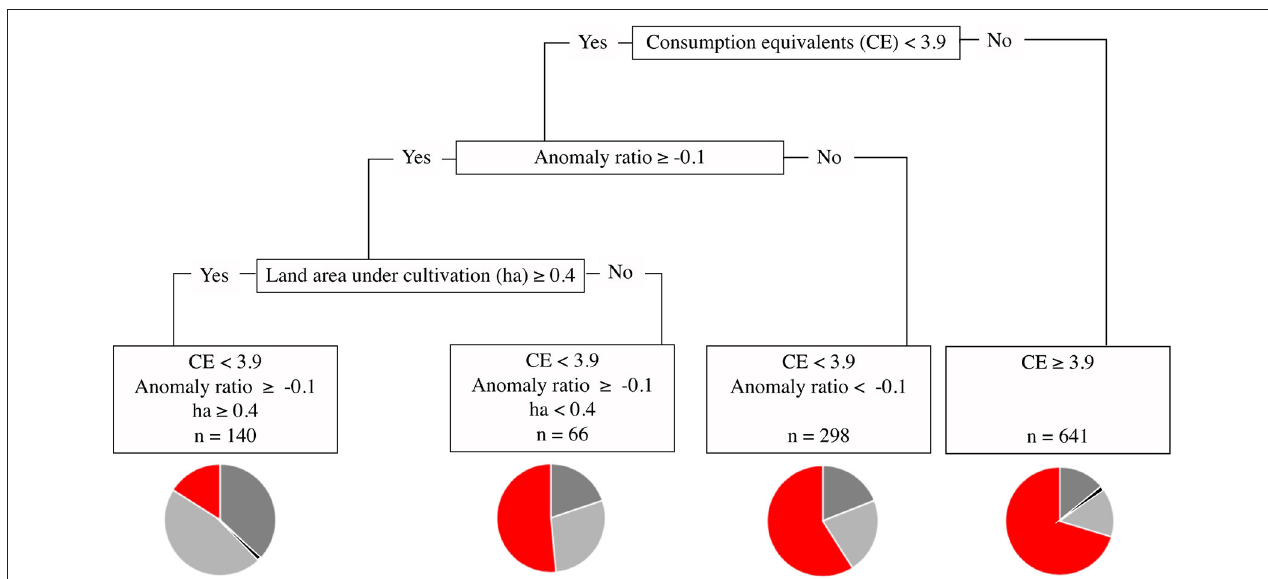
FIGURE 3 | Logistic model tree for households in Ethiopia household. Three groups of households are represented as terminal nodes. Tropical livestock units and the anomaly ratio of the last seasons’ rainfall predict food availability status.